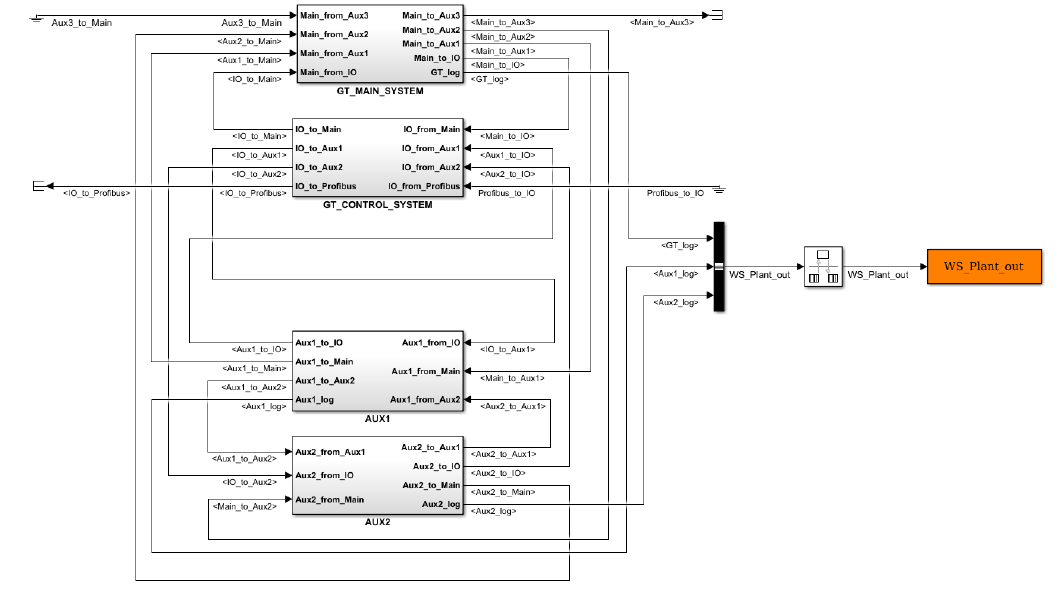
Figure 2. TGSim Plus™ main model. Top level architecture.